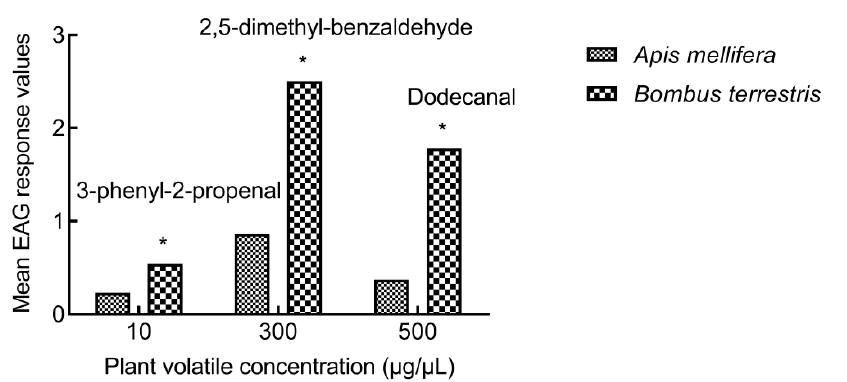
Figure 4. Comparison of EAG responses between A. mellifera and B. terrestris to 3-phenlyl-2- propenal, 2,5-dimethyl-benzaldehyde, and dodecanal. “*”means significant difference ( p < 0.05).